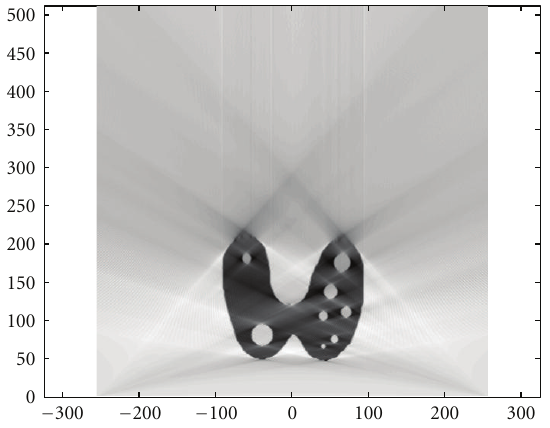
Figure 21: FBP-IM reconstruction of the thyroid phantom with dω = 0 . 0025 rad.